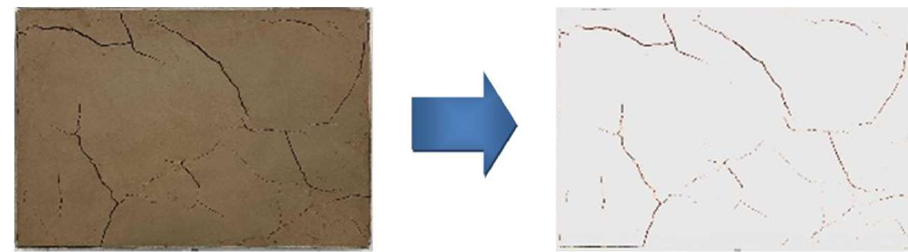
Figure 2. Image processing process.